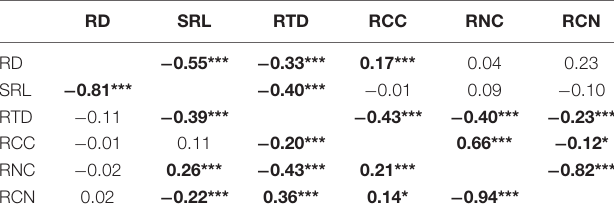
TABLE 1 | Correlation coefficient matrix of the six root traits using Pearson’s correlation analysis (lower-left diagonal) and phylogenetic independent contrasts (PICs, upper-right diagonal) for all